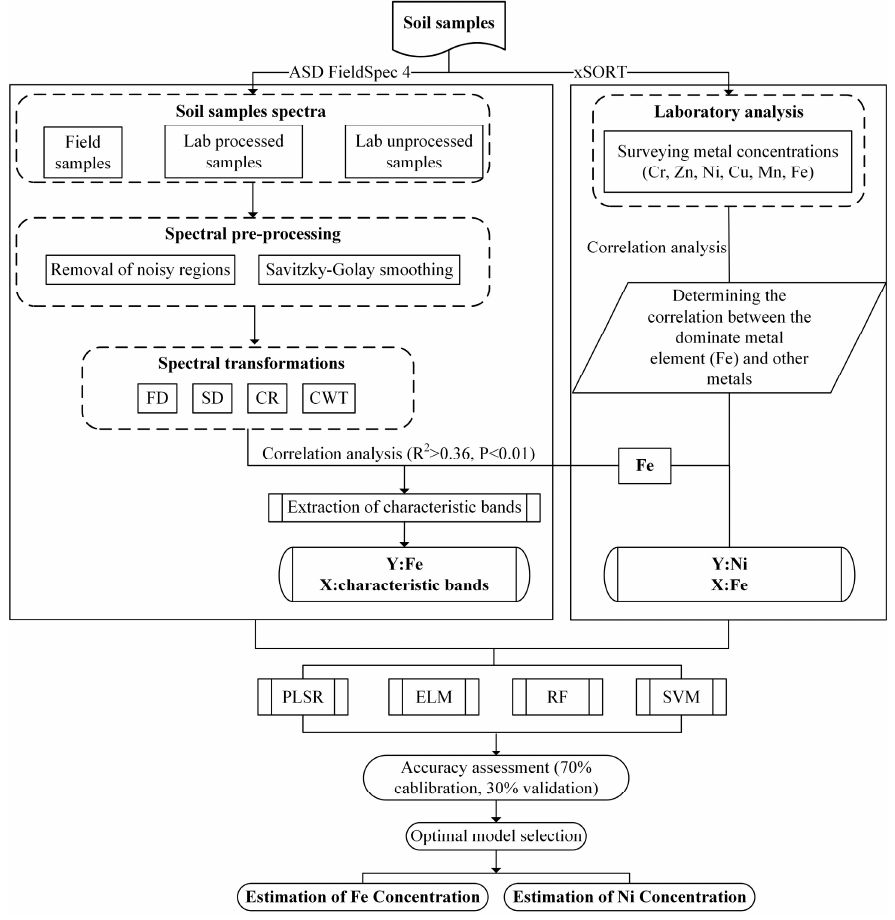
Figure 1. Workflow of the present study.